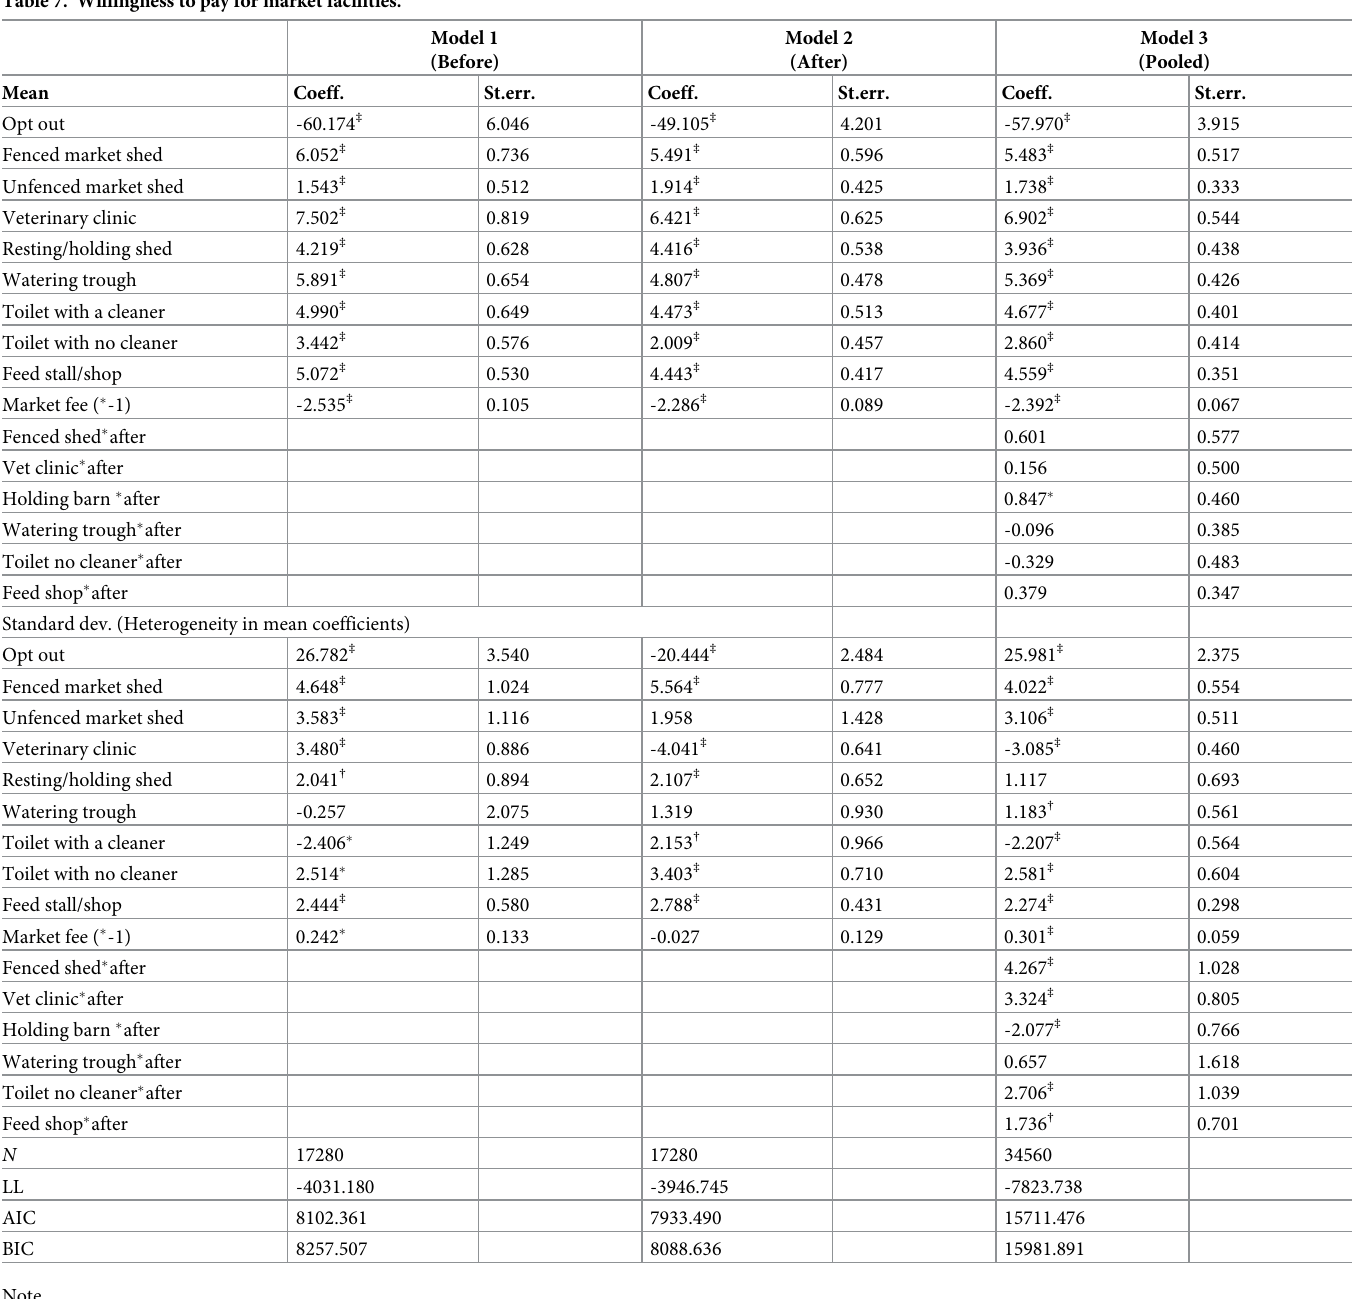
Table 7. Willingness to pay for market